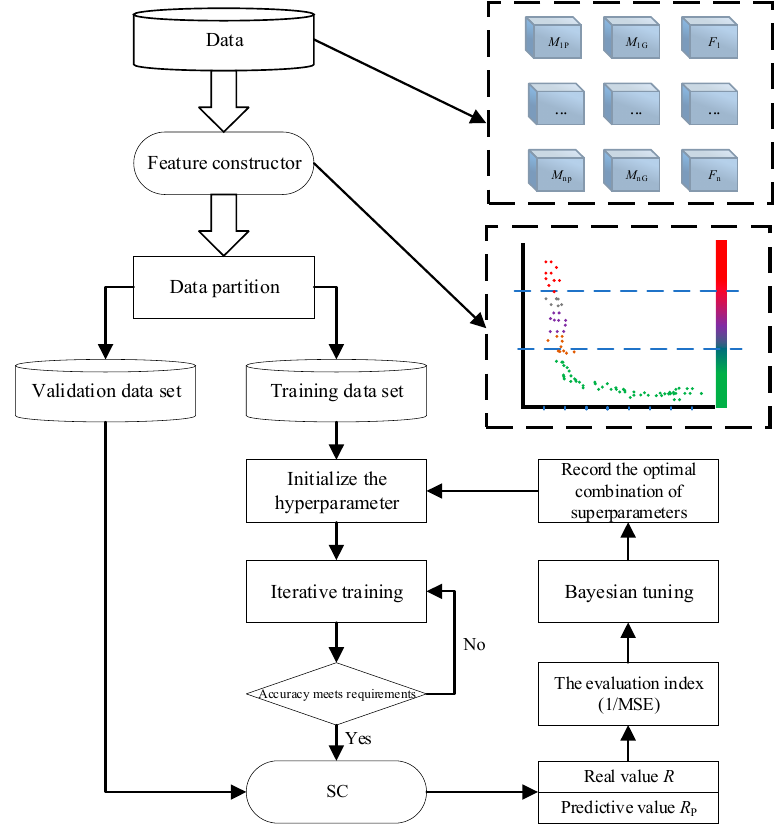
Figure 2. Fixed-curvature roll-bending forming coupling analyzer training process.